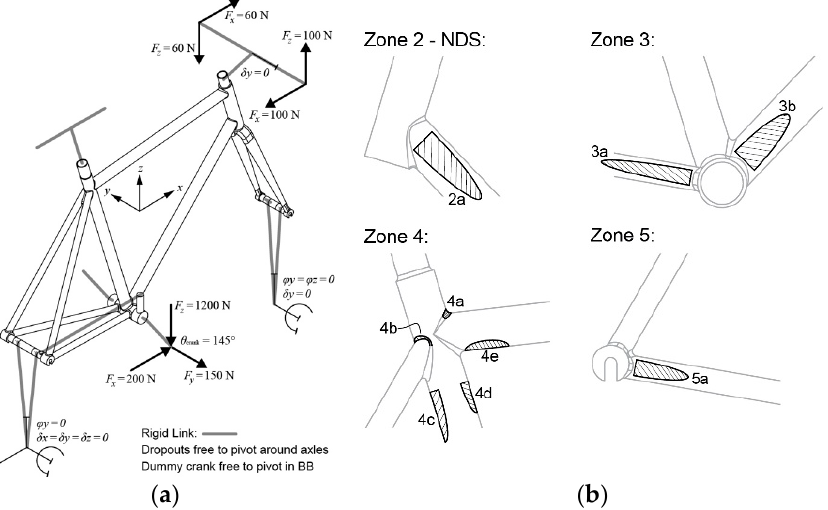
Figure 2. A recent example of modelling and simulation on steel bicycle frames: ( a ) FEA has been applied to bicycle frames with load cases based on field measurements [3]; ( b ) Areas of high stress for specific load cases can be identified and evaluated